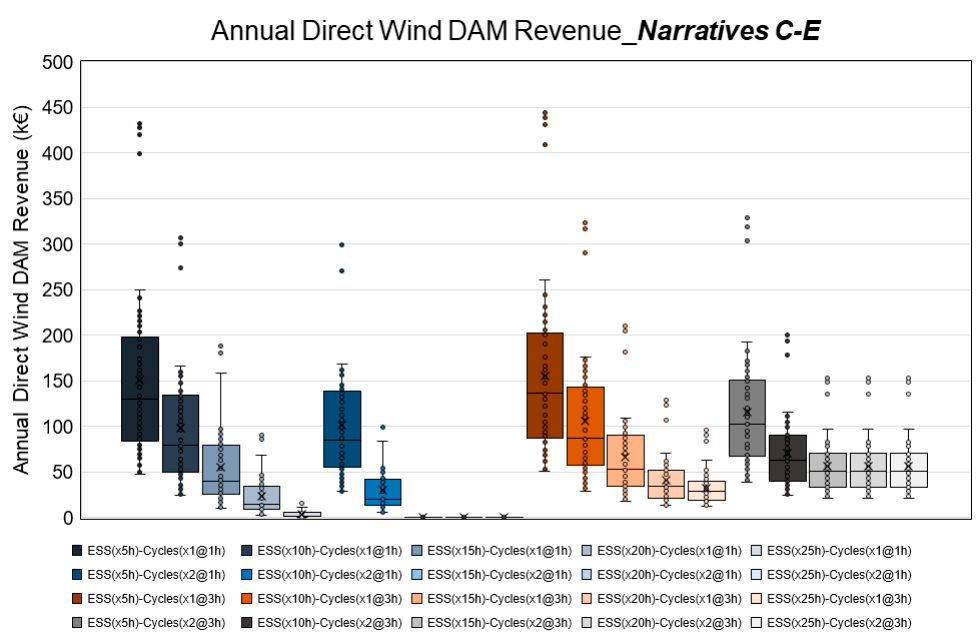
Figure 12. Annual revenue from excessive wind power shares delivered to the market per di ff erent storage con fi guration and cycling option, under the assumption of no dispatchability